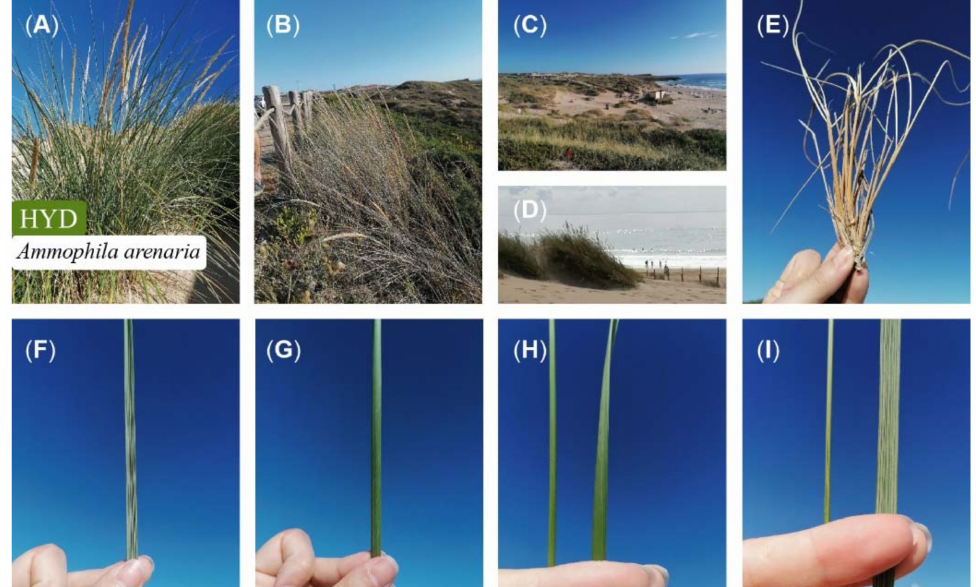
Figure 4. Photographic record of A. arenaria . ( A – D ) marram grass; ( E ) general form; ( F ) adaxial face and ( G ) abaxial leaf face; ( H , I ) comparison between a completely rolled leaf and an unrolled leaf. Source: